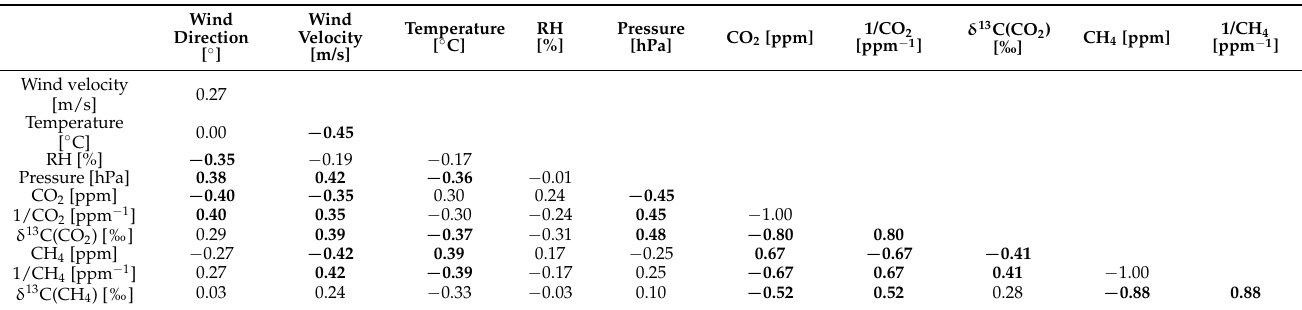
Table 3. Spearman’s rank correlation coefficient between analyzed parameters ( n = 32). Statistically significant coefficients for p < 0.05 are